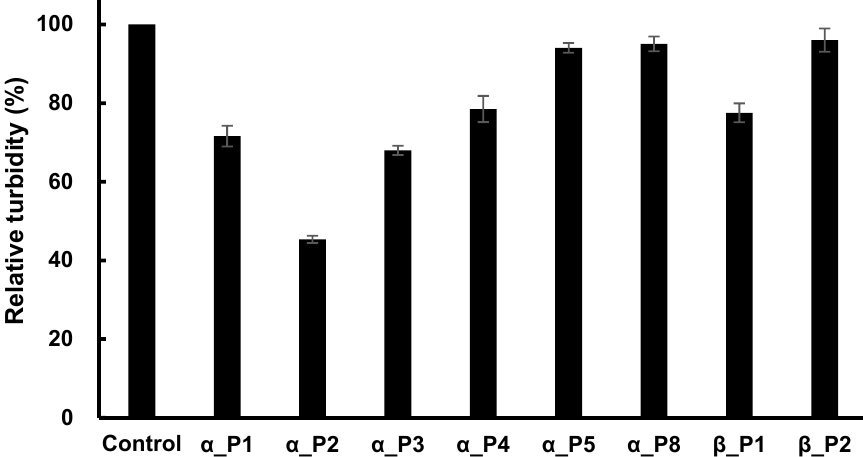
Figure 3. The relative activity of microtubule polymerization of P. capsici as a function of the fixed concentration of inhibitory phages. A fixed concentration of each phage (10 nM) was treated initially with the polymerization assay mixture for 40 min of reaction time. The percent inhibition of the peptides was as follows; α _P1, 28%; α _P2, 54%; α _P3, 32%; α _P4, 19%; α _P5, 5%; α _P8, 4%; β _P1, 21%; β _P2, 2%.